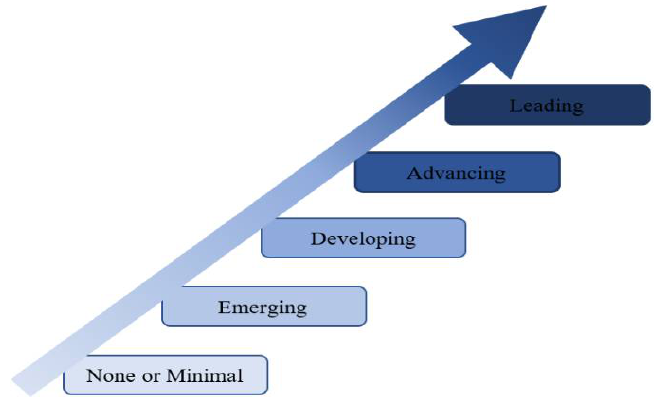
Figure 2. Energy maturity model (Adapted from Finnerty et al. [56]) .